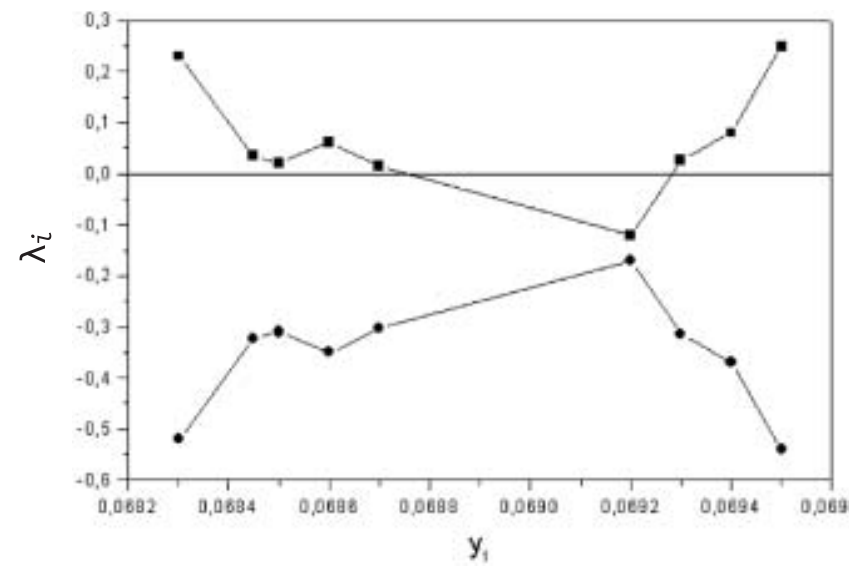
Fig. 10. Lyapunov exponents for different values of δ and θ = 0 . 7 .